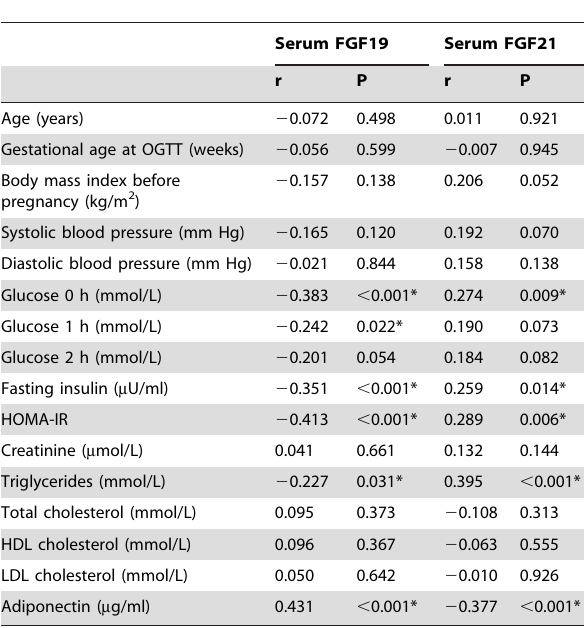
The correlations were calculated in the combined population of GDM patients and controls. Units and abbreviations are as Table 1.